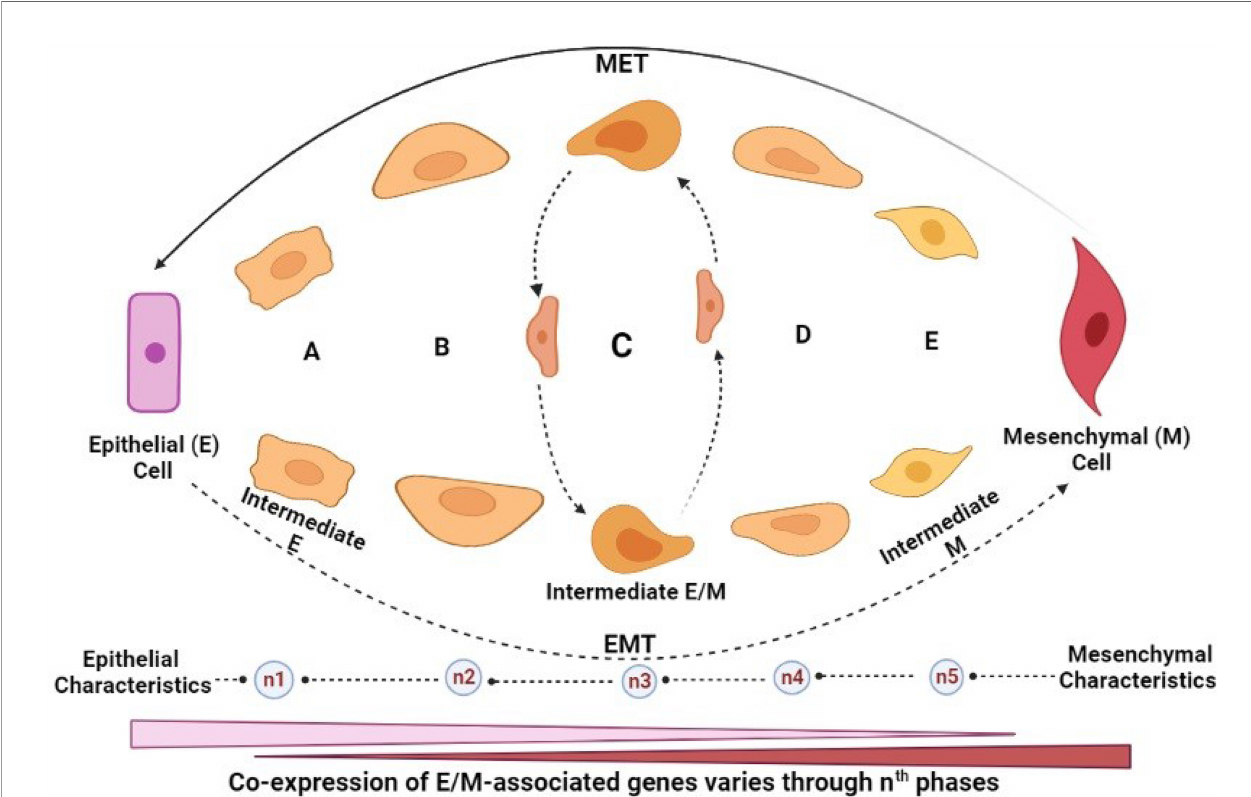
FIGURE 3 | EMT/MET intermediates. (A – E) Intermediate cells: hybrid/partial EMT (pEMT) cells. n th: The transition phase indicates the number of transitions that may occur before M cells are formed, which is indeterminate but could be dictated by many factors including the tumour microenvironmental cues. Intermediate cells possess dynamic characteristics that are central to increased metastatic potential. Hybrid/pEMT “ C ” : indicates an unspeci fi c hypothetical stage. The time taken (known as fi rst arrival time (FAT) distribution) for E or M cells to transition to each other, or individual pMET/hybrid cell at the n th phase varies depending on (i) epigenetic changes (histone modi fi cation or methylation), (ii) presence of anti-EMT/pro-MET factors (such as OVOL 1/2, GRHL-2, ESRP-1/2, and various microRNAs (including miR20 family), among others. Generally, the stability of hybrid E/M is controlled by some factors known as phenotypic stability factors (PSFs) and their metabolic, genomic, and morphologic states. However, as these intermediate cells possess some similar characteristics, they also have different phenotypic behaviours. They possess identical properties such as tumour-initiating potential but are also signi fi cantly contrastive, based on (i) cellular plasticity, (ii) degree of invasiveness, and (iii) metastatic potential. Among all the intermediate phenotypes, however, intermediate M possesses the highest migratory potential, the highest degree of invasiveness, most primed to form spindle-shaped phenotype and the highest resistance to